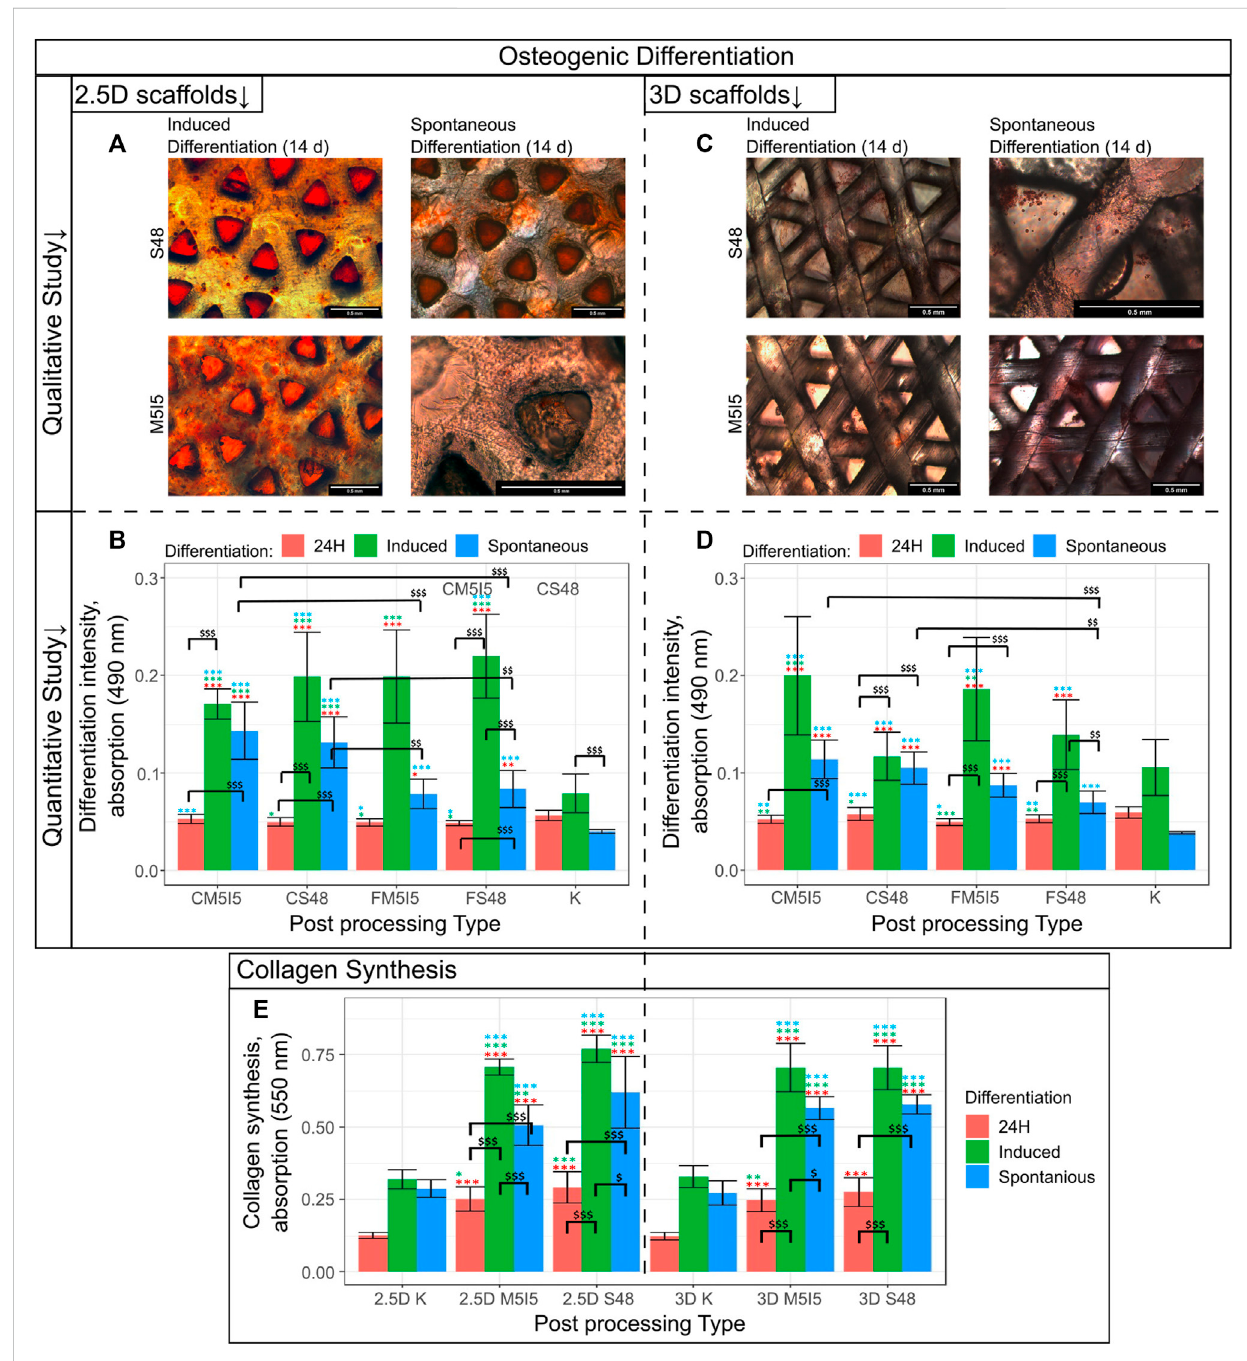
FIGURE 6 Results of the qualitative and quantitative study on osteogenic differentiation (A) Quantitative evaluation of cells grown on a 2.5D scaffold differentiation, where the intensity of differentiation corresponds to the absorbance at 570 nm; (B) Qualitative evaluation of cells grown on 2.5D Clear scaffold differentiation; (C) Quantitative evaluation of cells grown on a 3D scaffold differentiation, where the intensity of differentiation corresponds to theabsorbanceat570 nm; (D) Qualitativeevaluationofcellsgrownona3D Clear scaffolddifferentiation.S48-soakinginSoxhletextractorfor48h, M5I5 - soaking in methanol and isopropanol for 5 days; C and F - Clear and Flexible materials. (E) Results of the collagen synthesis